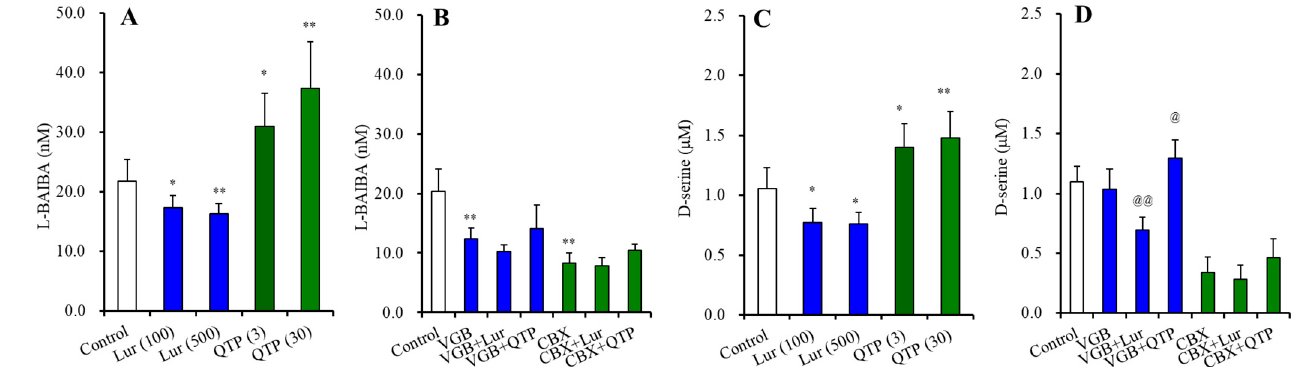
Figure 9. Effects of chronic exposures of lurasidone (Lur: 100 and 500 nM for 14 d) and quetiapine (QTP: 3 and 30 µM for 14 d) on intracellular levels of IP3 ( A ), cAMP ( B ), AMP ( C ) and ATP ( D ) in astrocytes. Ordinate: mean ± SD ( n = 6) of levels of IP3, cAMP (fmol/mg) and AMP, ATP (pmol/mg) in the rat cultured astrocytes. * p < 0.05, ** p < 0.01: relative to control by ANOVA with Tukey’s post hoc test.